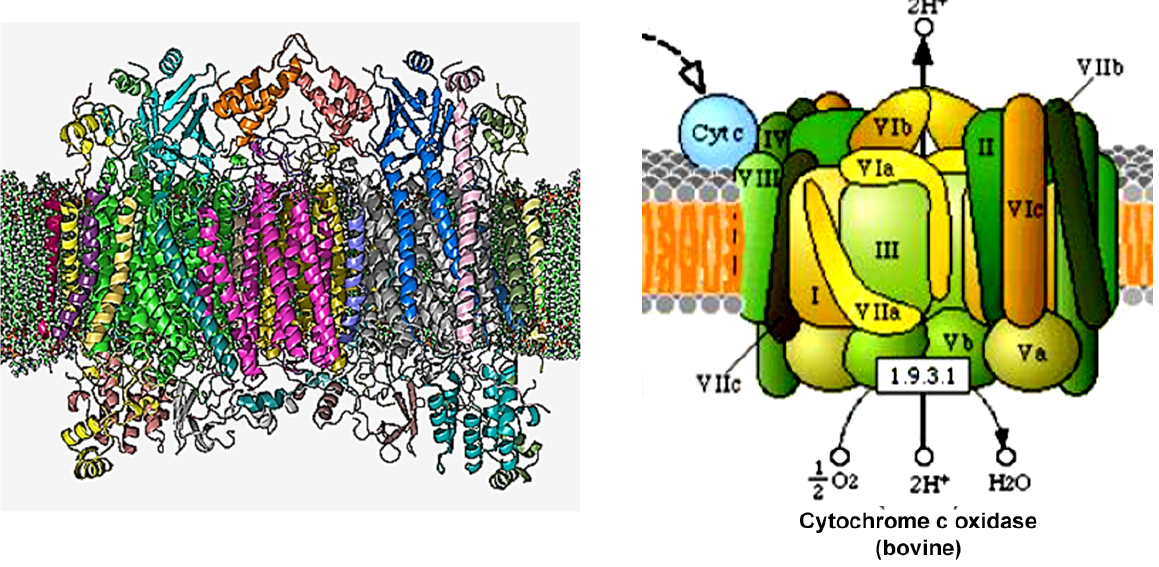
Figure 7. ( Left ) The crystal structure of bovine homodimer cytochrome c oxidase in a phospholipid Figure 7: (Left) The crystal structure of bovine homodimer cytochrome c oxidase in a bilayer. Adapted from The Protein Data Bank (PDB) PDB: 1OCC. PDB structures: RCSB PDB PDBe PDBsum. Diagrammatic representation of COX’s subunits in different colors. ( Right ) A diagram of phospholipid bilayer. Adapted from The Protein Data Bank (PDB) PDB: 1OCC. PDB COX taken from the KEGG pathways (https://www.genome.jp/kegg-bin/show_pathway?map00190 structures: RCSB PDB PDBe PDBsum. (Right) A diagram of COX taken from the KEGG accessed on 5 February pathways (https://www.genome.jp/dbget-bin/www_bget?path:map00190 accessed on 05 February 2022 ).